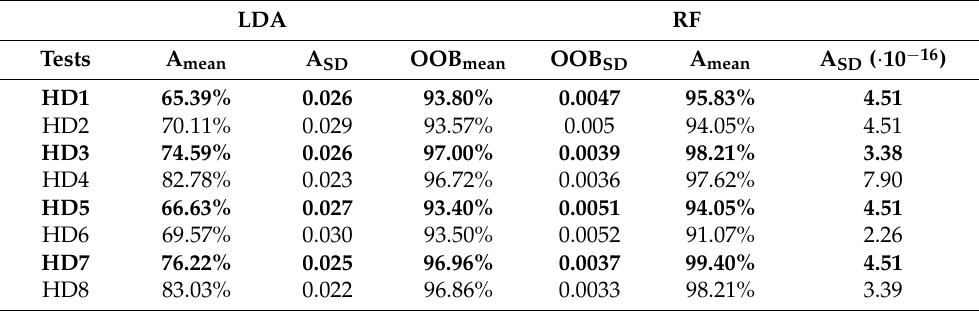
Table 4. Results of the performed tests on the complete dataset of data acquired by heathy subjects and pathological patients. For each data sample, mean and SD of accuracy A are presented for LDA and RF, and of OOB for RF. In bold font the data referring to tests without distinction of left and right limb.